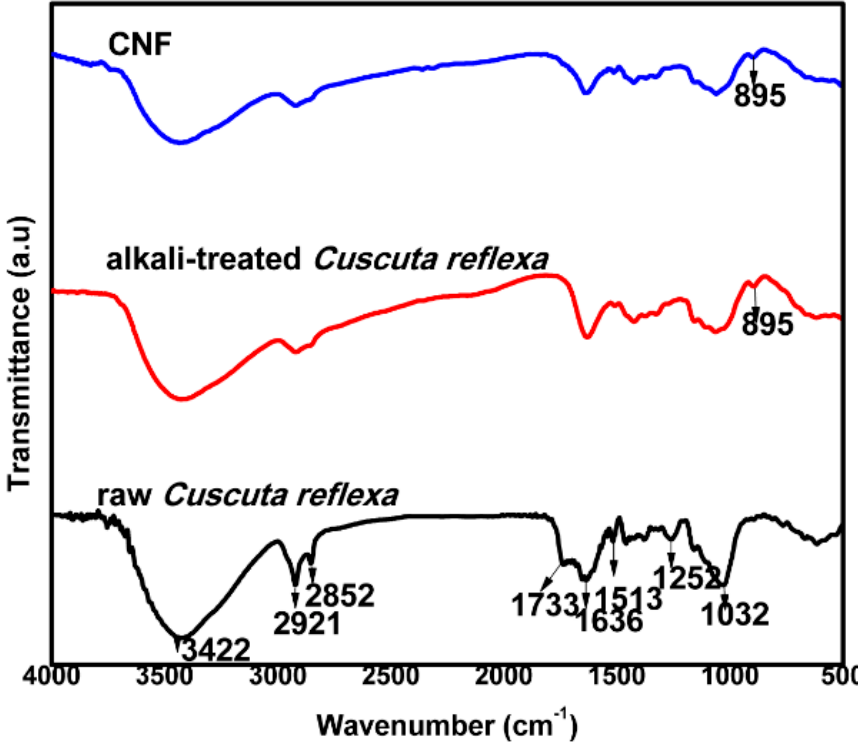
Figure 1. Fourier Transform Infrared Spectroscopy (FTIR) analysis of raw Cuscuta reflexa , alkali-treated Cuscuta reflexa, and CNF.